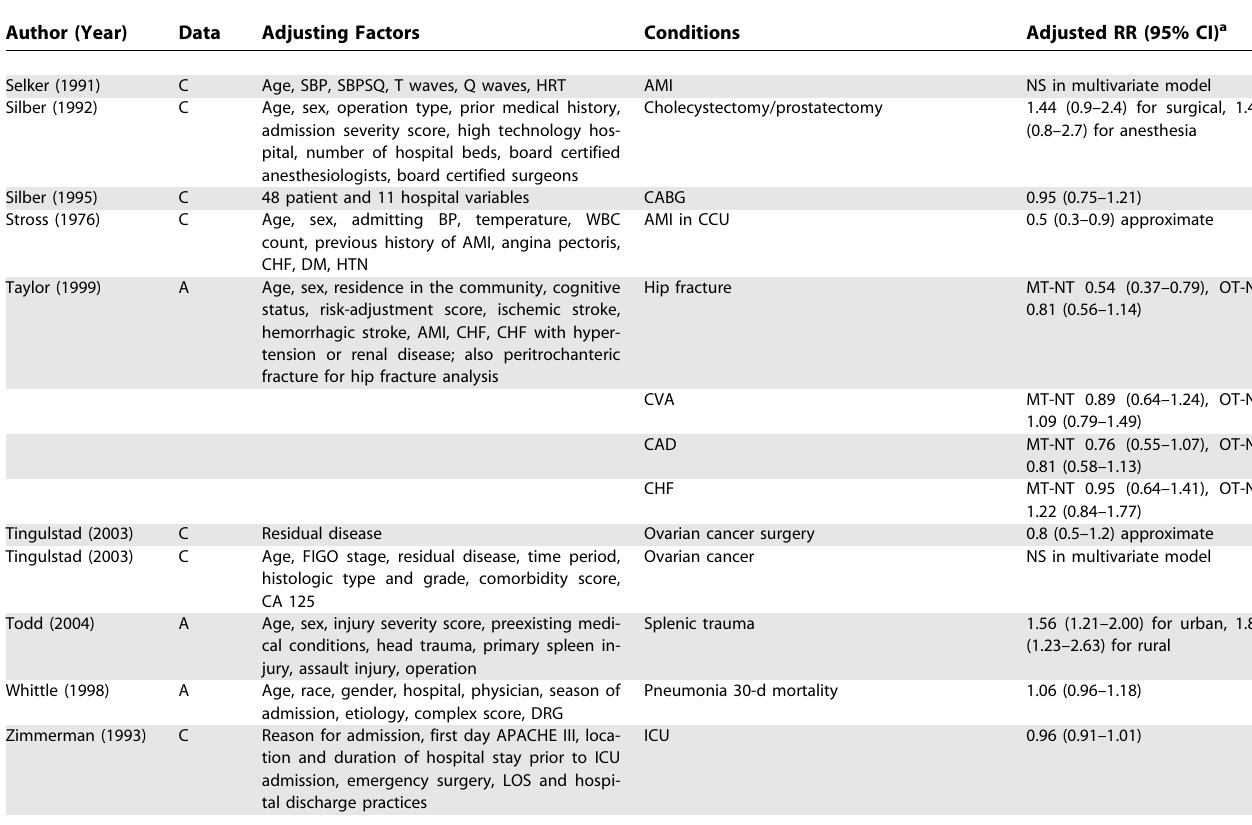
[Figure 2]) for teaching versus nonteaching healthcare structures. Between-study heterogeneity was considerable ( p , 0.001; I 2 ¼ 72%). However, there was no evidence that studies with smaller weight had different estimates from studies with larger weight (tau correlation coefficient (cid:1) 0.03; p ¼ 0.71), and the same was true when administrative database studies were examined separately from clinical